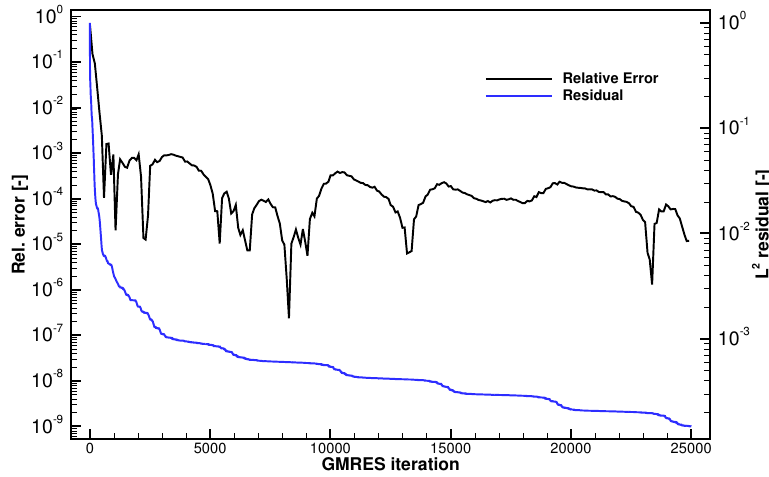
Figure 5. Relative error of work coefficient and L 2 residual over GMRES iteration for σ = 0 ◦